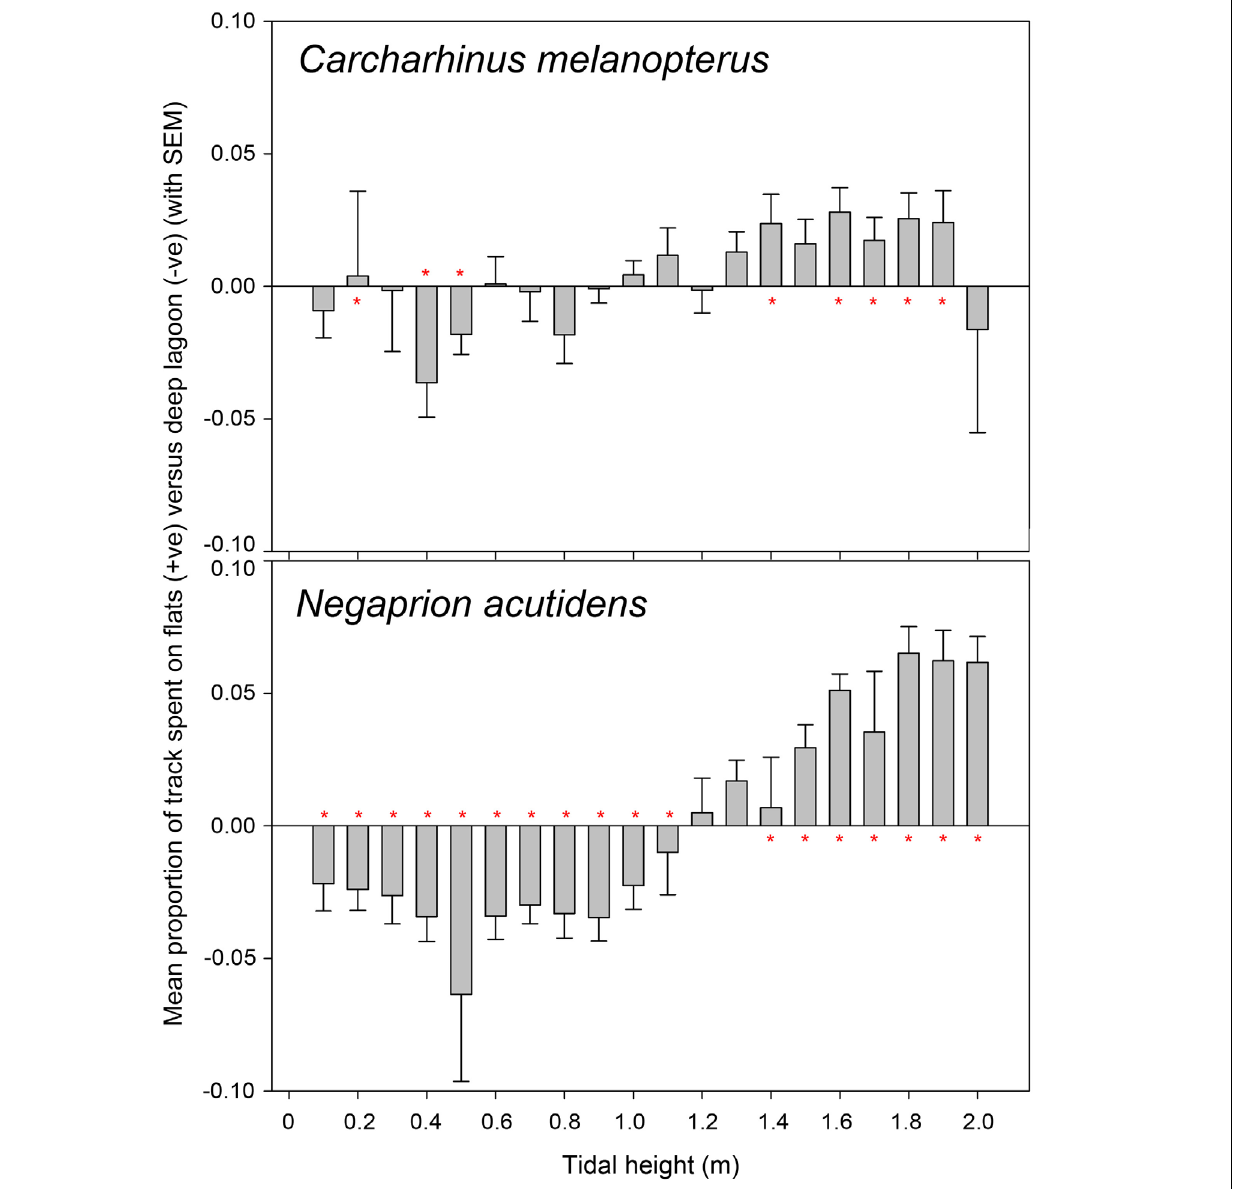
FIGURE 2 | Mean relative difference in the proportion of detections between the shallow flats and deep lagoon for blacktip reef shark Carcharhinus melanopterus and sicklefin lemon shark Negaprion acutidens across the tidal cycle. Calculated for each individual as the relative proportion of flats detections minus the relative proportion of lagoon detections, then averaged for each 10 cm tidal height bin. Positive values denote a bias toward flats usage, with negative a bias for deep lagoon usage – values around 0 suggest no difference. Error bars represent the standard error of the mean. Red asterisks by bars show where medians for that group significantly differed from 0 (no difference) as shown in Supplementary Table S1